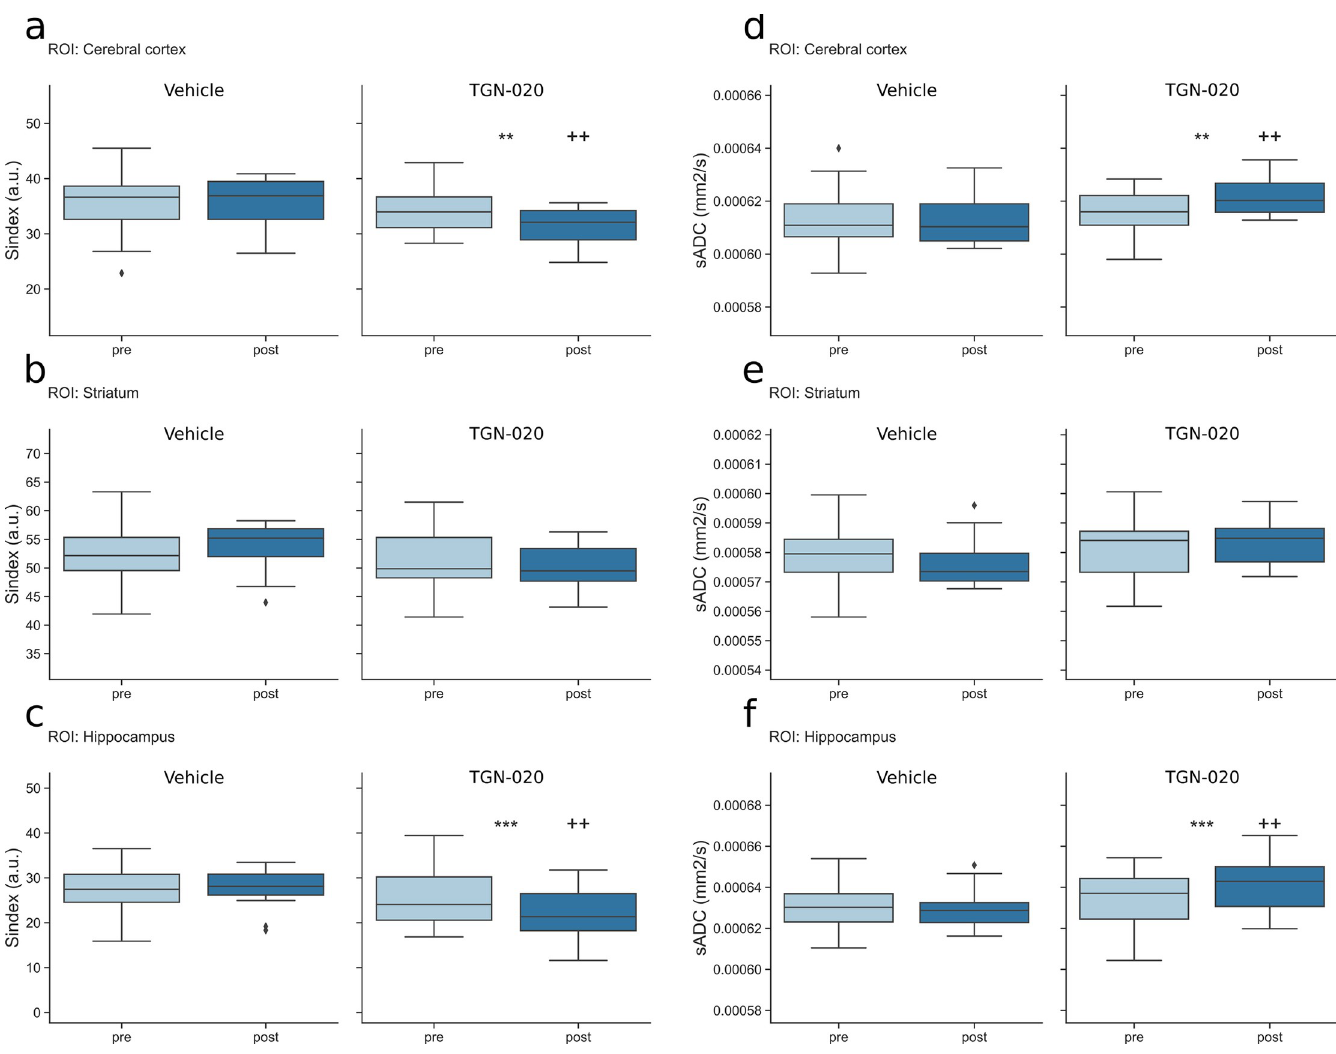
Fig 4. Boxplot of Sindex and sADC in the cortex (a: Sindex, d: sADC), the striatum (b: Sindex, e: sADC) and hippocampus (c: Sindex, f: sADC). Left, Vehicle group; right TGN-020 group in each figure. Pre, pre-injection (light blue); post, post-injection (dark blue) of vehicle or TGN-020 group. � : p < 0.05, �� : p < 0.01, ��� : p < 0.001 are the result for the paired t-test between pre and post-injection for each group. +: p < 0.05, ++: p < 0.01, +++: p < 0.001 are the result for a t-test with posthoc correction for multiple comparison between post-injection of the two groups. Diamonds represent outliers, a point is defined as an outlier if its value is below Q1–1.5 × IQR or above Q3 + 1.5 × IQR, where Q1 is the first quartile, Q3 the third quartile and IQR the interquartile